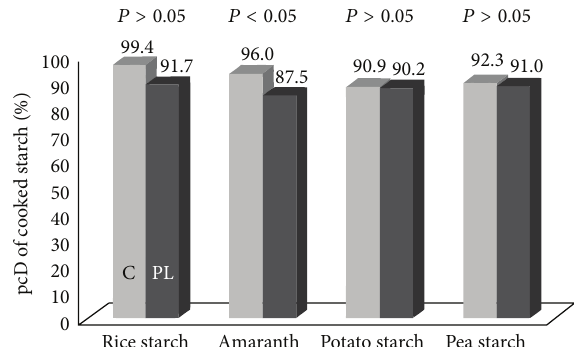
Figure 2: pcD of different sources of starch fed after thermal treatment to control-pigs (C, light grey bars) and pancreatic duct ligated pigs (PL, grey